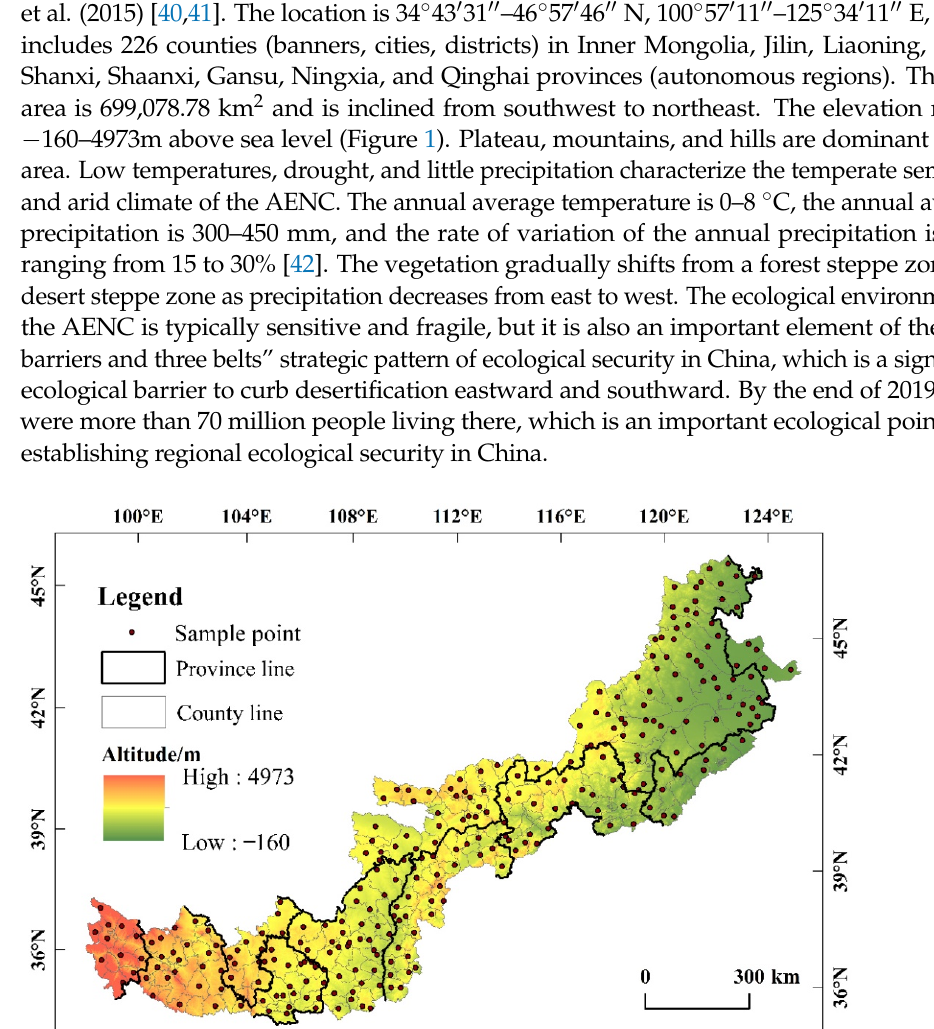
Table 1. Main data types and sources. Data Types